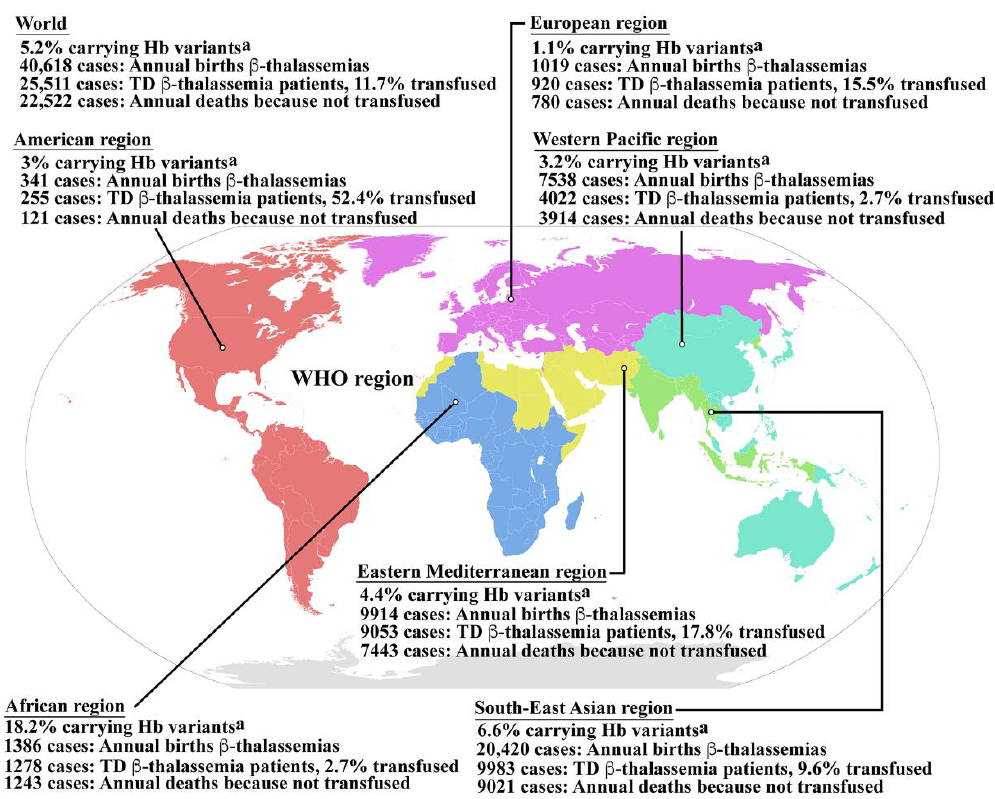
Figure 1. Epidemiology of β -thalassemia. Global epidemiological data including the percentages of populations carrying Hb variants, the number of newborns who have β -thalassemias per year, the number of patients who have TDT, and the percentage of TDT patients who are reached for blood transfusion, and the number of patients who died as a consequence of not receiving blood transfusion worldwide and in the individual sub-regions, according to the World Health Organization (WHO) as reported by Modell B and Darlison M published in the Bull World Health Organ 2008, 86, (6), 480–487 [13]. a Hemoglobin variants including HbS, HbC, HbE, HbD, etc., β -thalassemia and α -thalassemia. Hb; hemoglobin, TD β -thalassemia; transfusion dependent β -thalassemia. Source of WHO region map; wikipedia.org (accessed in September 2022). The map is in the public domain.